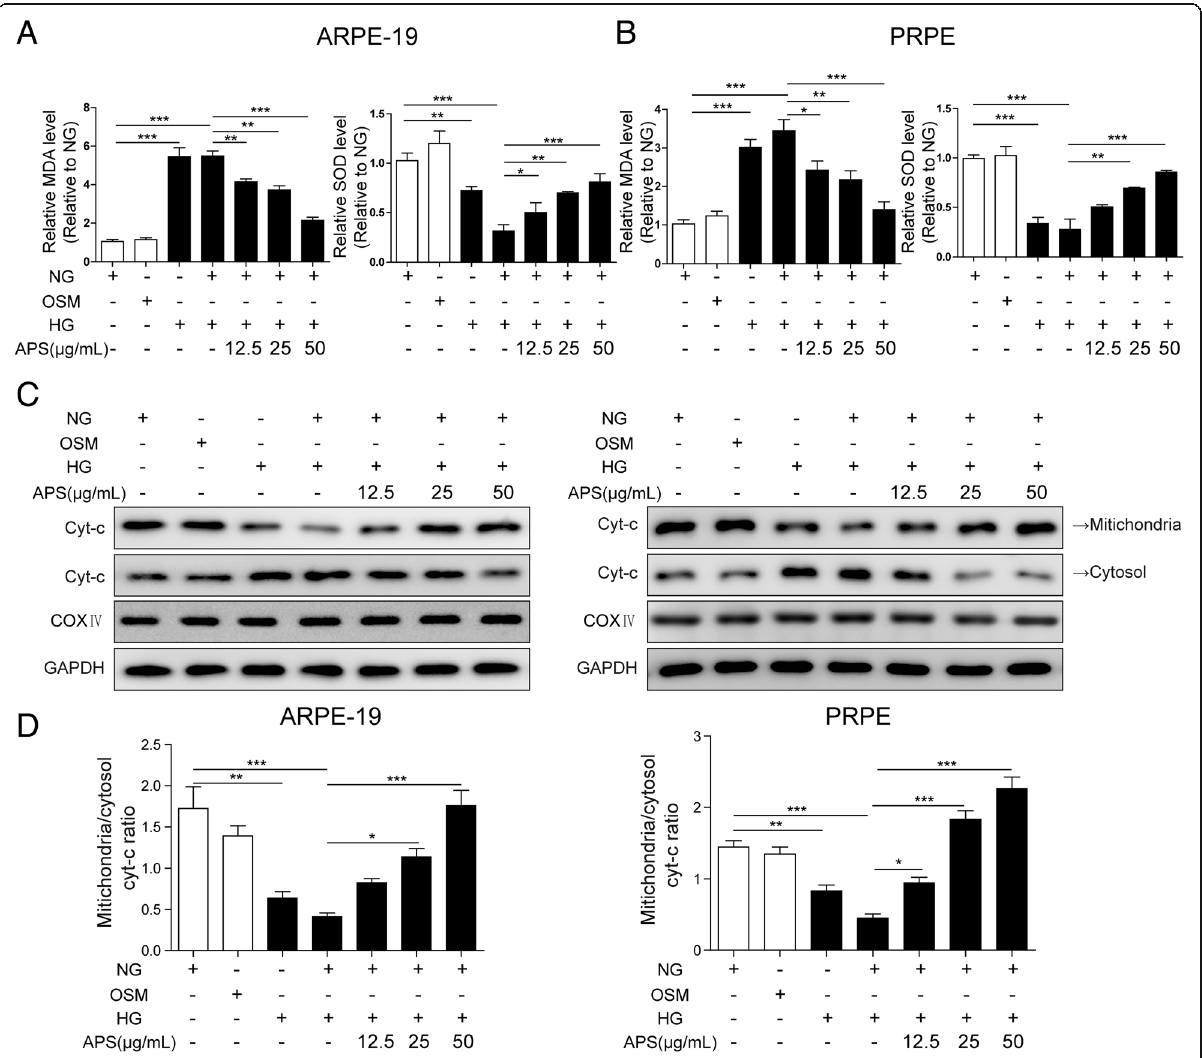
Fig. 3 APS reversed the oxidative stress and mitochondrial damage in RPE cells induced by HG. a Treatment with APS significantly decreased the MDA and increased SOD level which were induced by HG or HG + NG treatment in ARPE-19 cells. b Treatment with APS significantly decreased the MDA and increased SOD level which were induced by HG or HG + NG treatment in PRPE cells. c Western blotting showed treatment with APS significantly increased the ratio of mitochondrial to cytosol cyt-c which induced by HG and HG + NG treatment in ARPE-19 and PRPE cells. d The statistical results of western blotting. Error bars represented mean ± SD. *** p < 0.001, ** p < 0.01, * p <